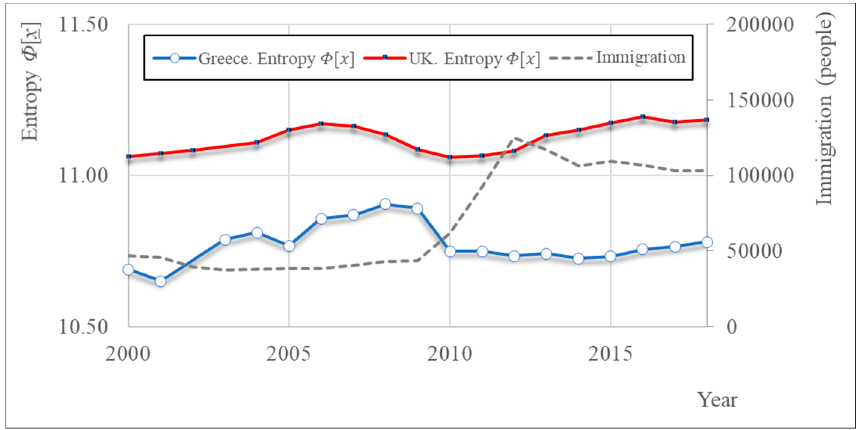
Figure 19. Greece and United Kingdom, timeline of total entropy Φ [ x ] and immigration flows from Greece to United Kingdom, over the same period.